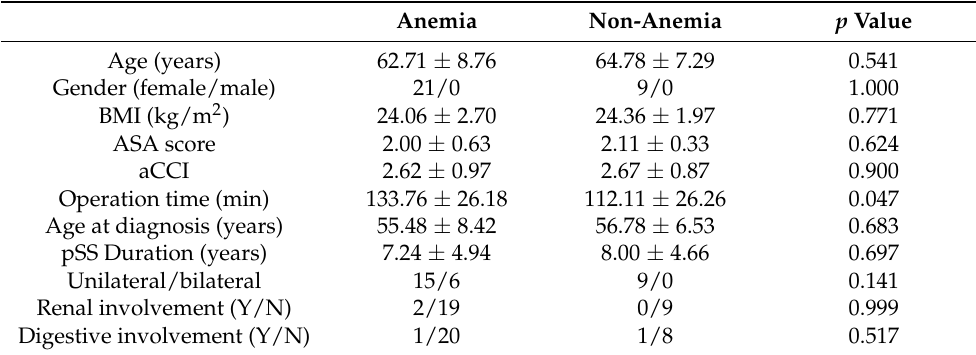
Table 6. Univariate analysis for postoperative anemia in pSS